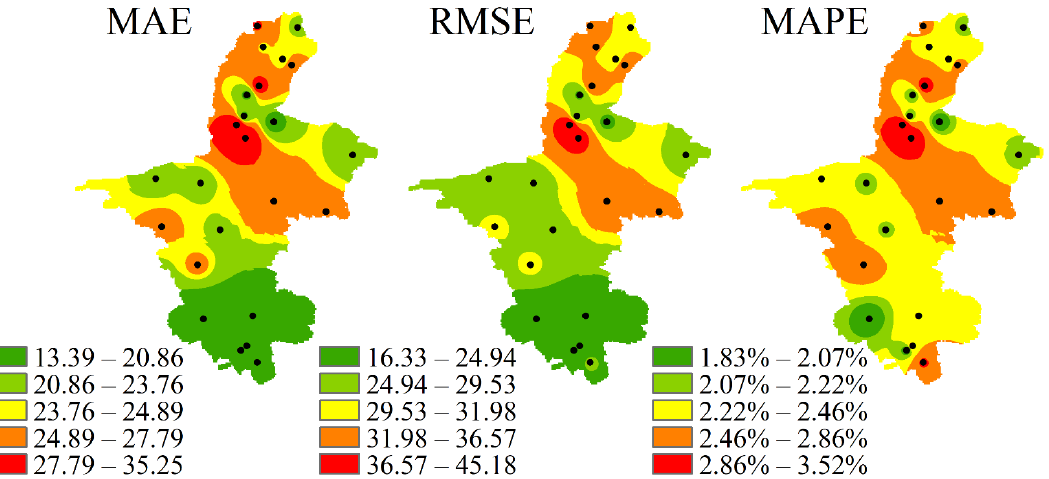
Figure 6. Fitting back-substitution error analysis (mean absolute error (MAE), root mean square error (RMSE), and mean absolute percentage error (MAPE)).